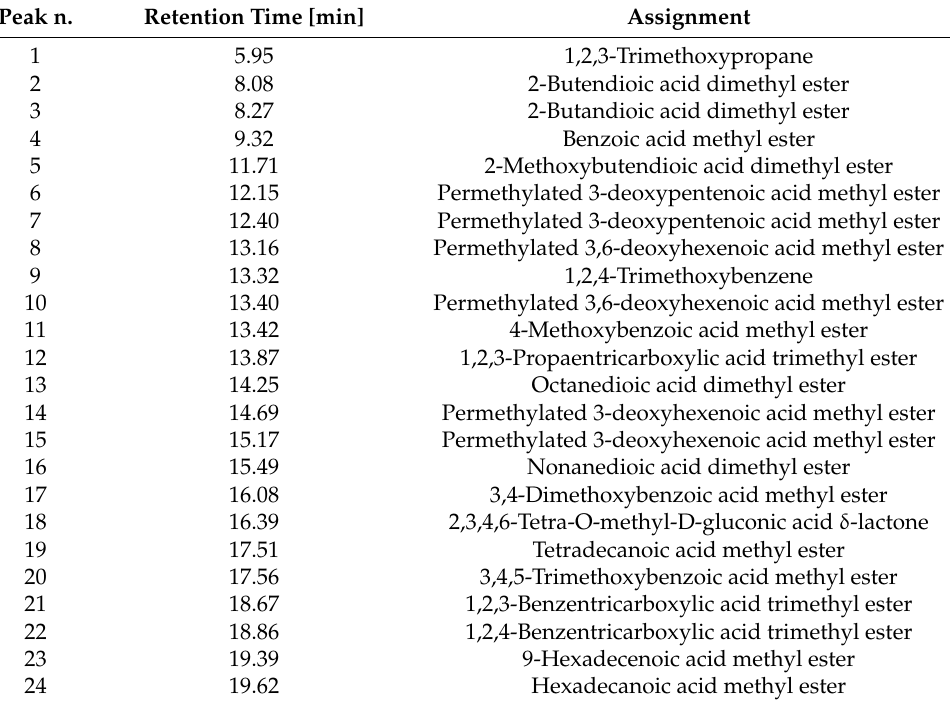
Table 3. Marker compounds of organic materials identified by Py-GC/MS in the brown surface layer of the sculpture. Peak